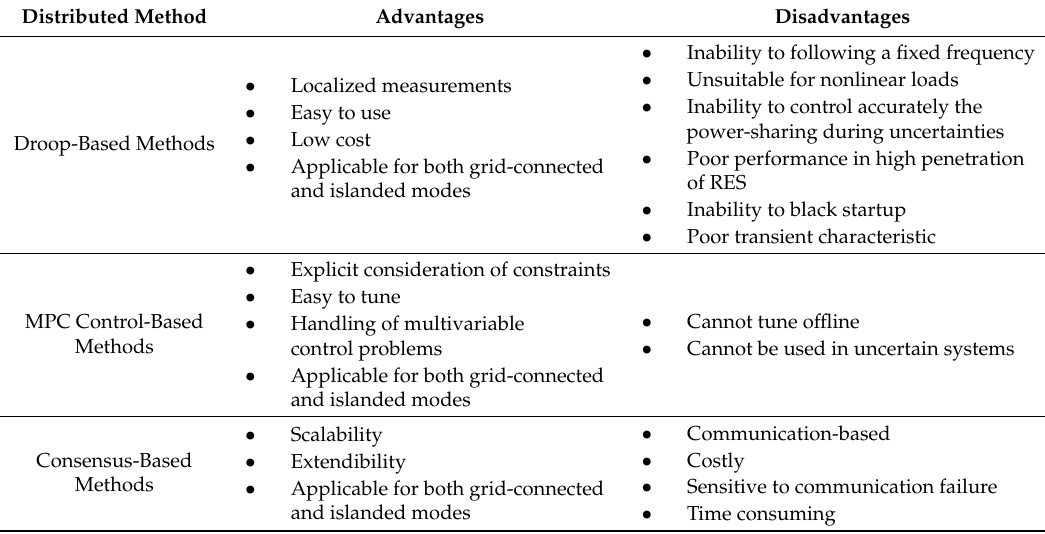
Table 1. The summary of the distributed